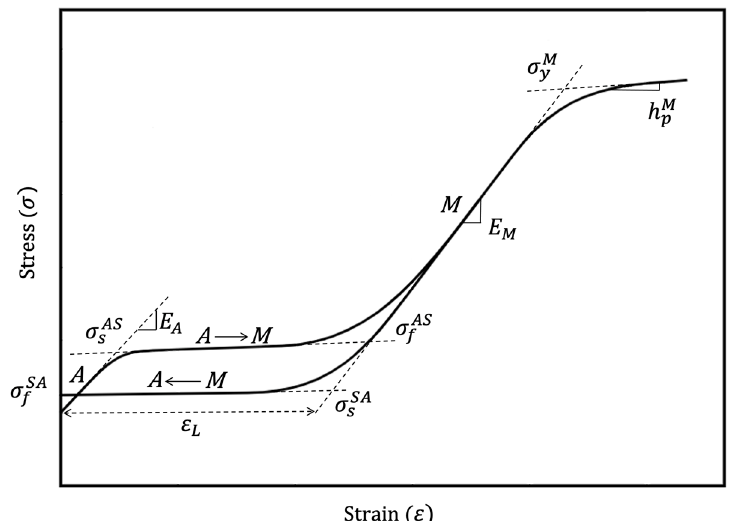
Figure 2. Schematic illustration showing the nomenclature used during phase transformations and mechanical loading. E A —Young’s modulus of austenite ( A ) phase; E M —Young’s modulus of martensite ( M ) phase; ε L —maximum longitudinal strain; σ AS s —stress to start martensitic transfor- mation (austenite to single-variant martensite); σ AS —stress at finish of martensitic transformation; f σ SA s —stress to start reverse transformation (single-variant martensite to austenite); σ SA —stress at f finish of reverse transformation; σ M y —martensite yield stress; h M p —martensite hardening ter.